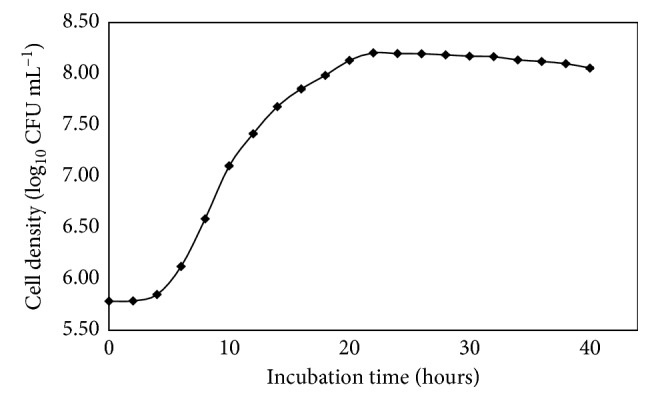
Growth curve of Bacillus megaterium in enriched medium. The bacteria reached the maximal value after 22 hours of inoculation in enriched medium. Therefore, we chose that time point (22 hours) for bacterial inoculation in induction medium to obtain the highest amount of viable bacteria.